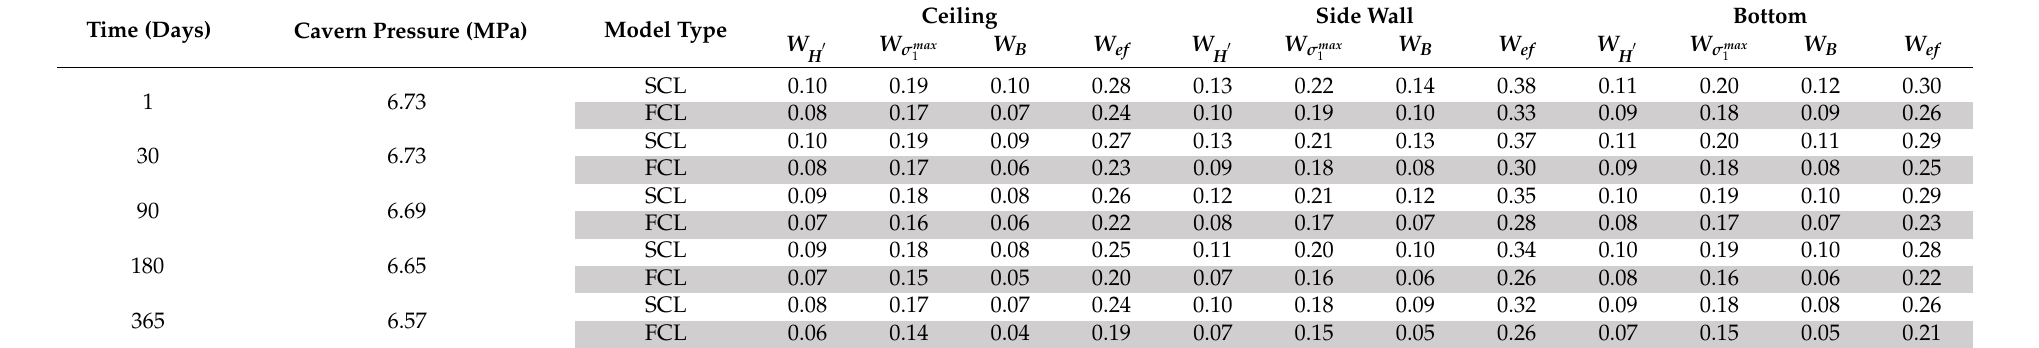
Table A3. Strength criteria for the two salt-creep models. Status at the end of the filling cycle (after injection to the maximum pressure). Time (Days)